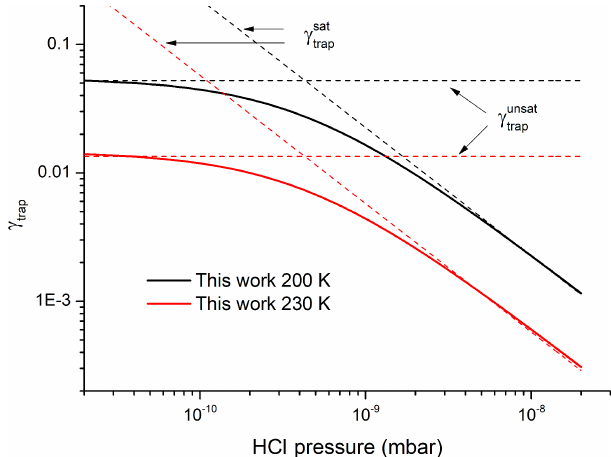
Figure 8. Comparison of γ trap from the present dataset, parame- terised according to Eq. (5) with the results of the modified trapping model from Kärcher et al. (2009) for the limiting cases of saturated and unsaturated uptake. The values of n ∗ derived from our data and used to calculate v esc and γ trap have been multiplied by a factor of 1.3 to improve agreement (see